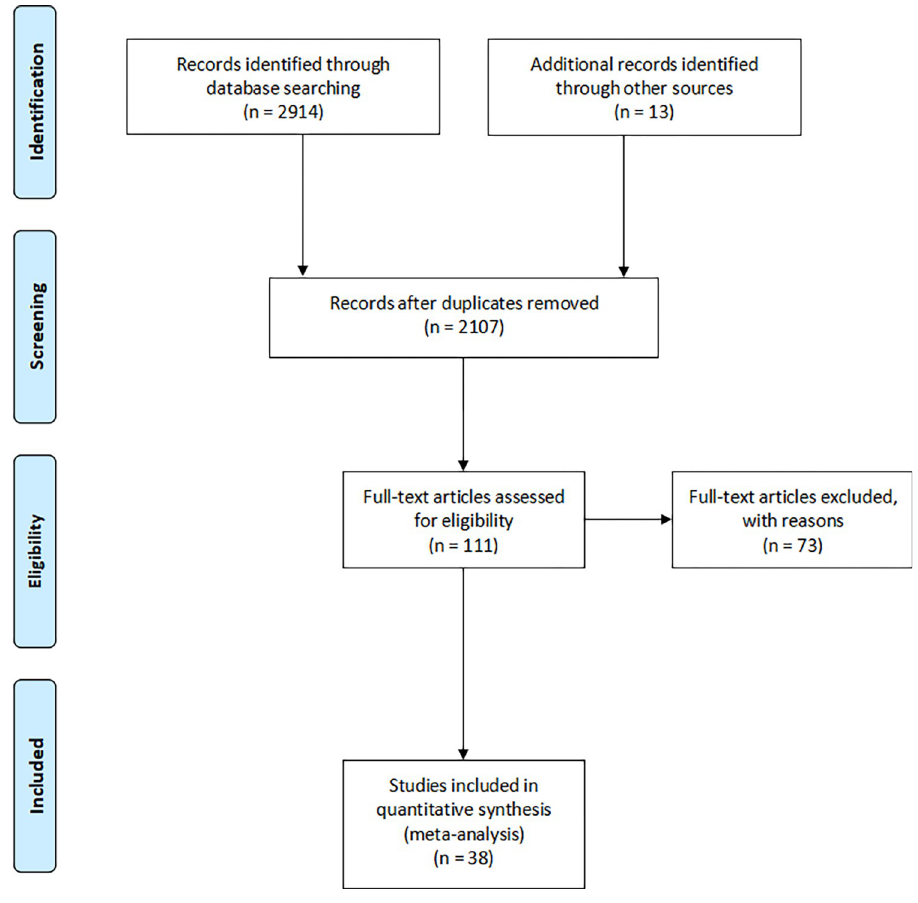
Fig 1. The PRISMA flow